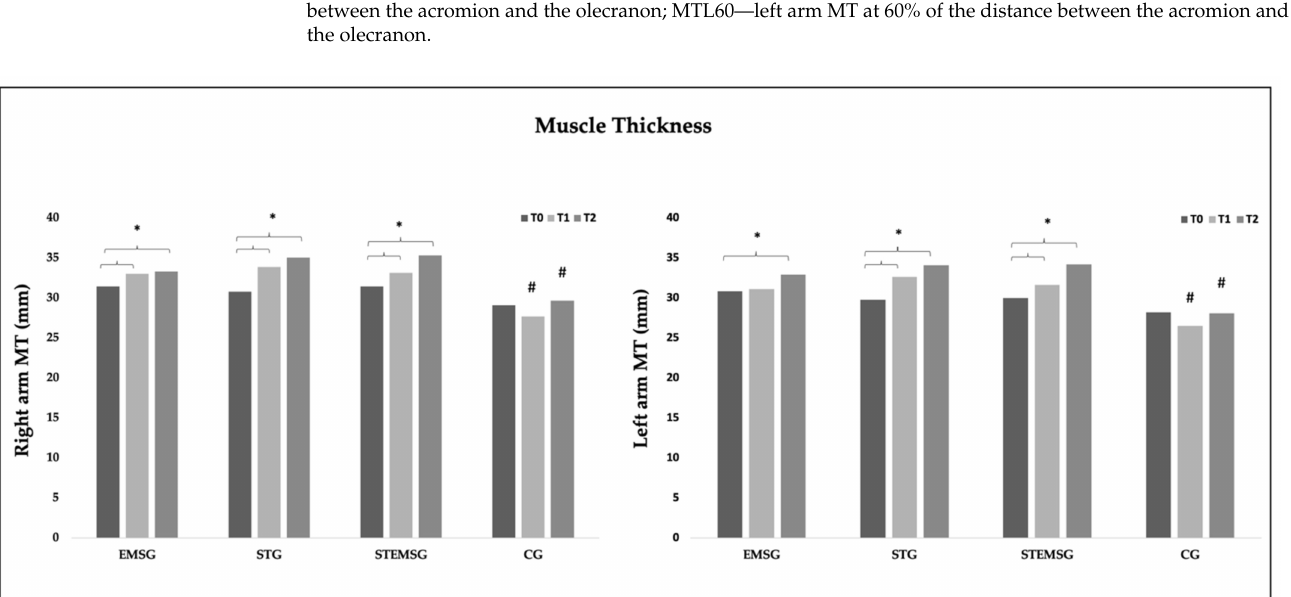
Figure 1. Mean ( ± SD) differences in the elbow flexors MT, of both arms, measured with ultrasound. EMSG—Group submitted to Electrostimulation Training protocol; STG—Group submitted to a Strength Training protocol; STEMSG—Group submitted to a protocol of Electrostimulation